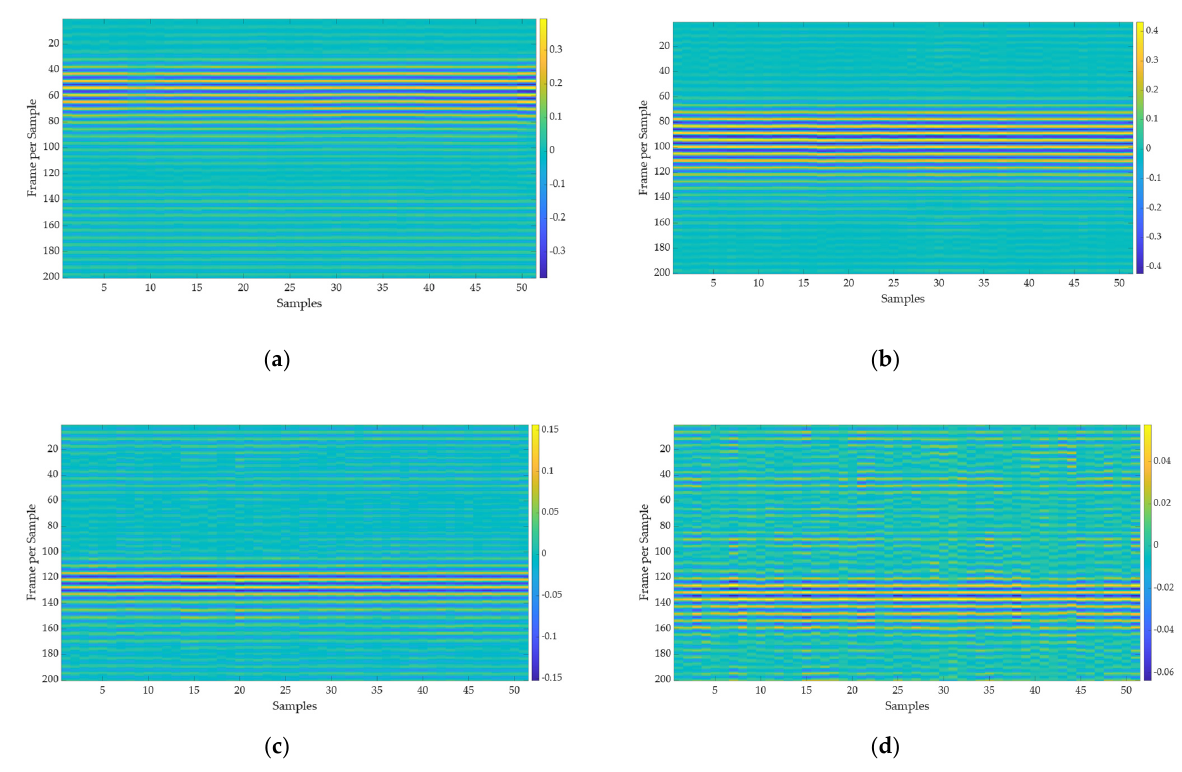
Figure 9. Scanned 2D holographic slices at different sleeping body positions in bed: ( a ) Right posi- tion; ( b ) Middle position; ( c ) Left position; ( d ) Without a presence in the bed.